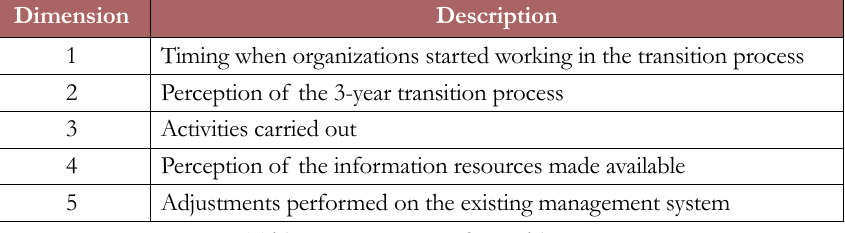
Table 1. Dimensions of Variable